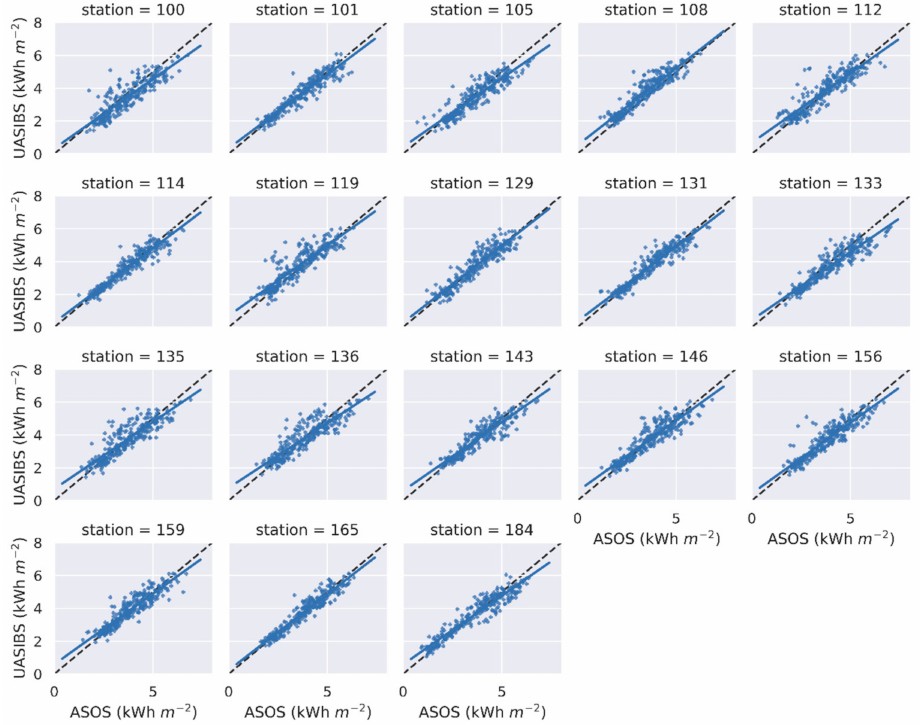
Figure 3. Same as Figure 2, but distributed for each ground